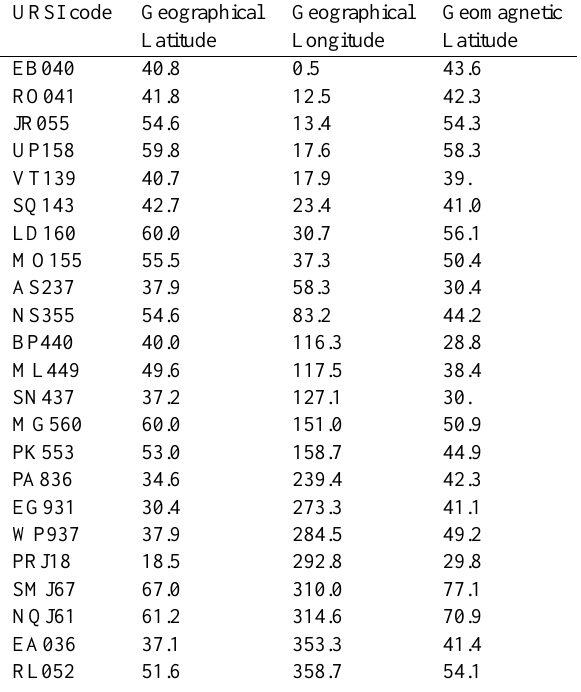
Table 1. List of the ionospheric stations used in the analysis URSI code Geographical Geographical